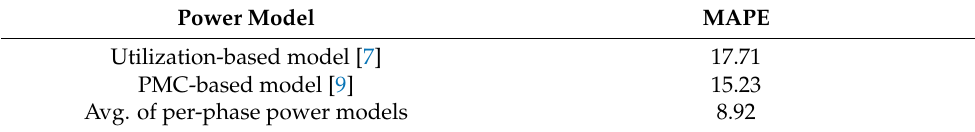
Table 7. Comparisons with existing GPU power models (unit: MAPE (%)). Power